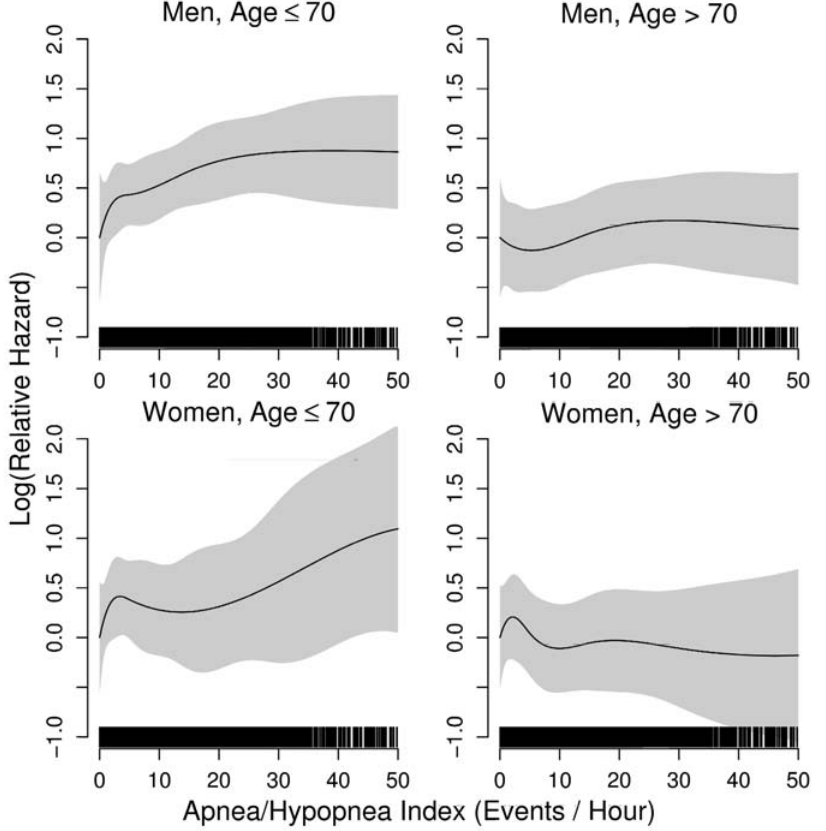
Figure 2. Spline regression models relating the apnea–hypopnea index (AHI) to the log(relative hazard) for all-cause mortality in men and women stratified by age ( # 70 and . 70 y).